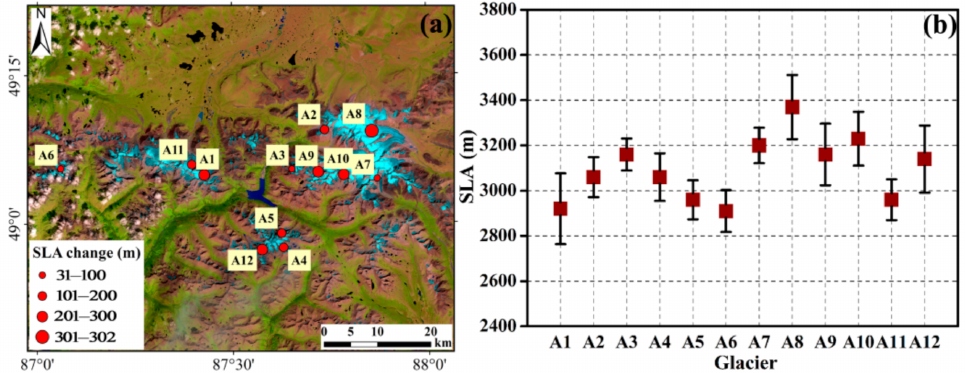
Figure 6. ( a ) SLA changes and ( b ) mean SLA of the 12 analyzed glaciers across the Altai Mountains during the 1989–2019 period. The error bars in ( b ) represent one standard deviation from the